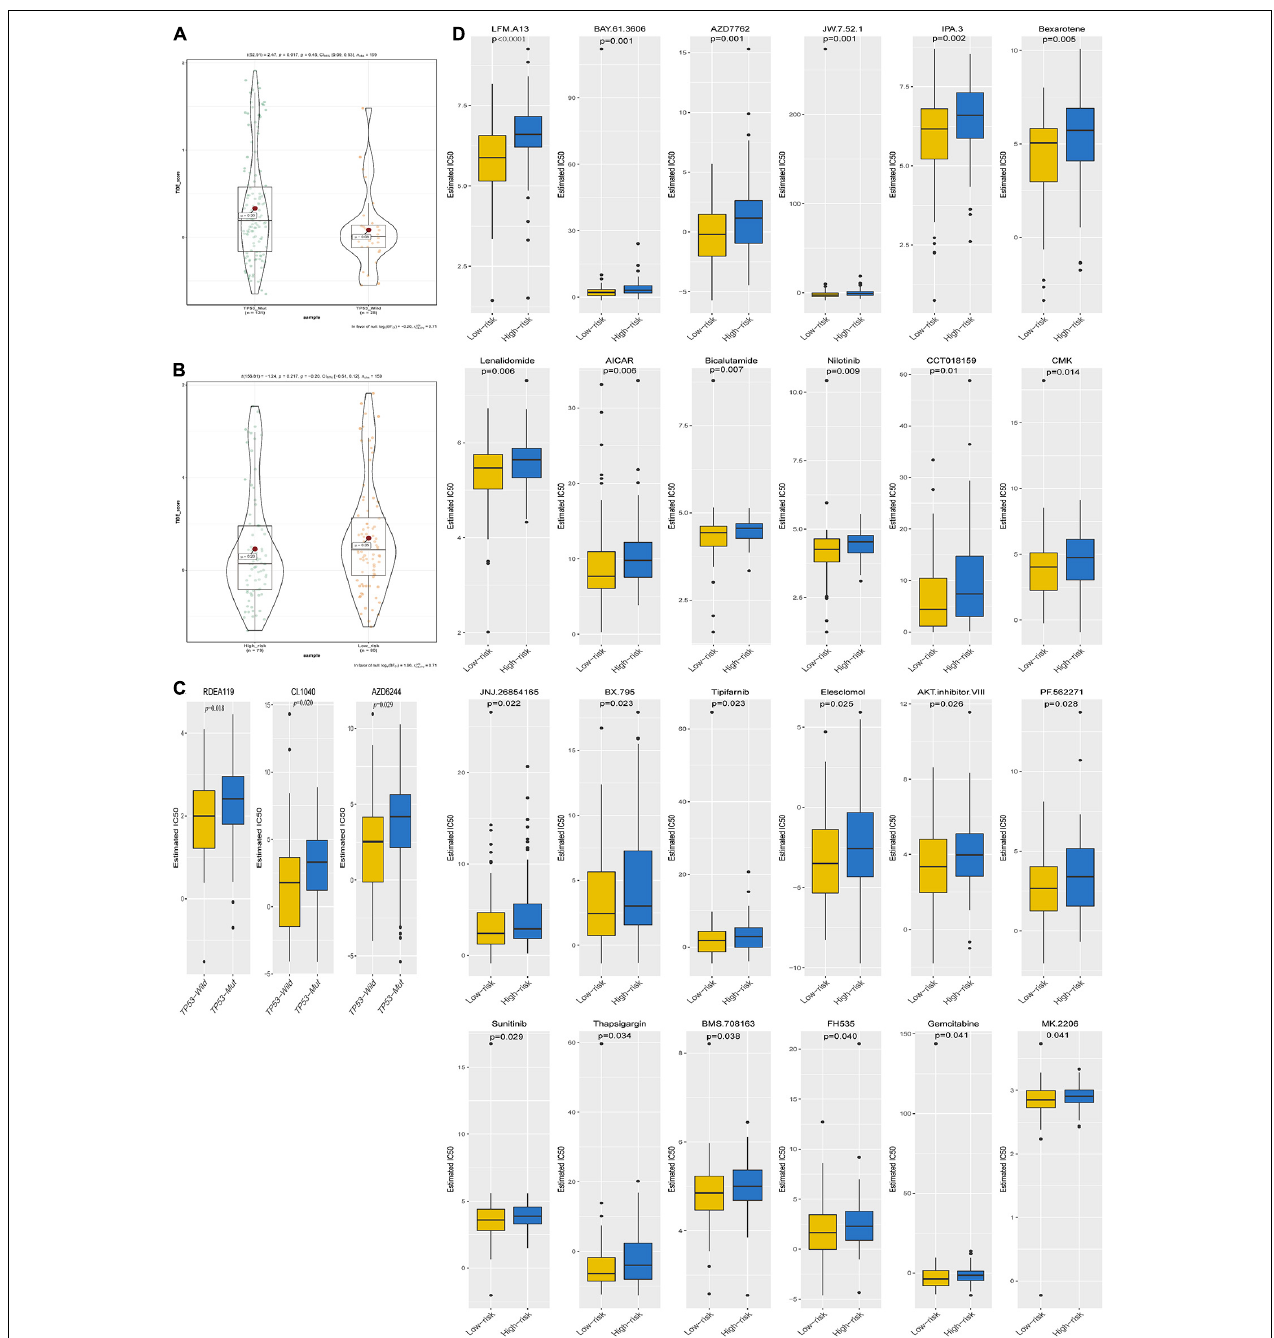
FIGURE 8 | Immunotherapeutic and chemotherapeutic responses in the TP53 WT and TP53 MUT cohorts and the high- and low-risk patients with ESCA (A,B) . Immunotherapeutic response to anti-CTLA-4 and anti-PD-1 treatments in the high- and low-risk patients and the TP53 WT and TP53 MUT cohorts. (C,D) Differential chemotherapeutic responses in the TP53 WT and TP53 MUT cohorts and the high- and low-risk